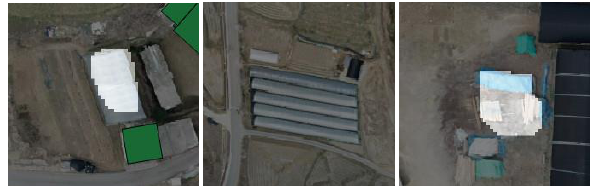
Figure 16. Example of ambiguous results in case of greenhouses (left and center) and wrong objects